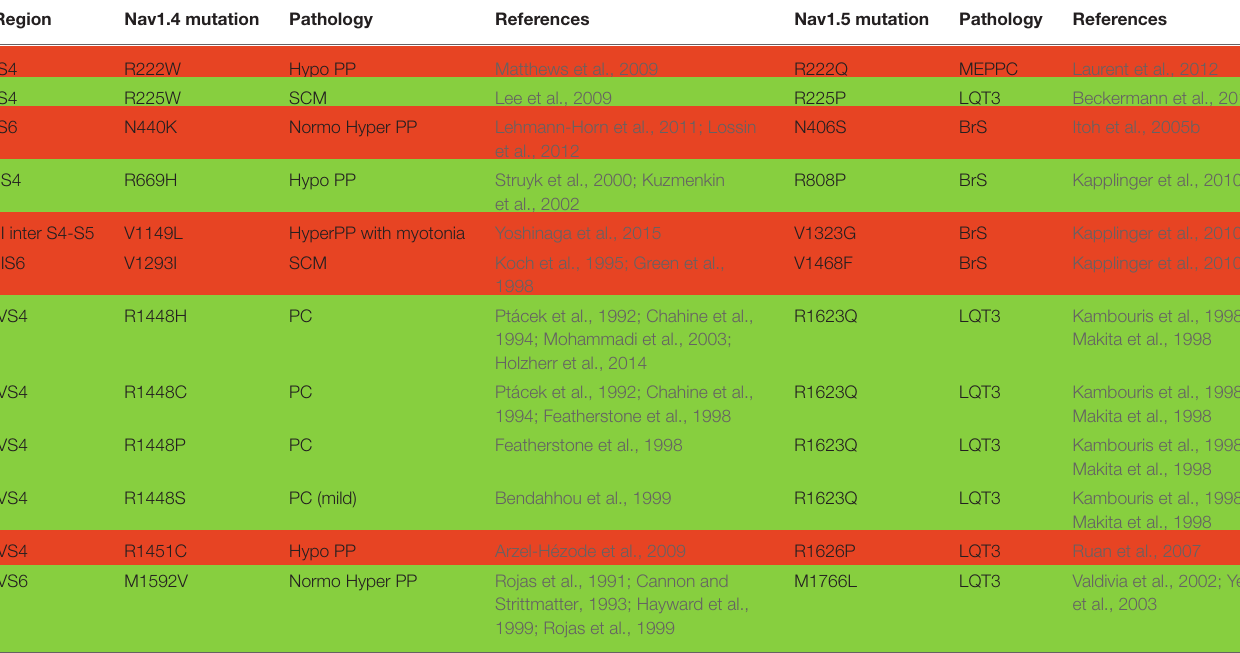
TABLE 5 | List of equivalent amino acids found to be differently mutated in patients with cardiac (for Nav1.5) or neuromuscular (for Nav1.4) pathologies.